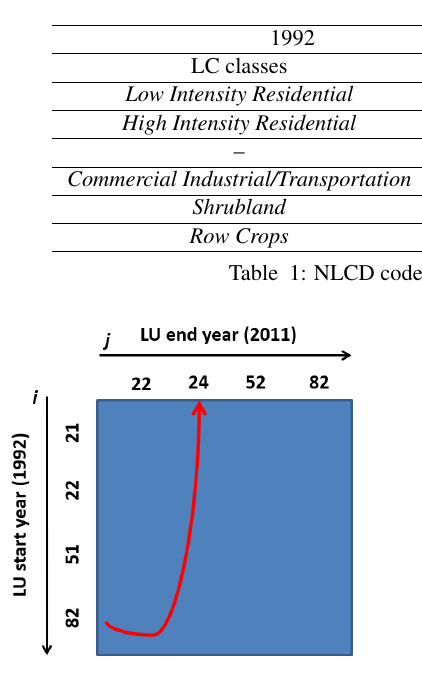
Figure 7: Matrix representation of the LC changes: the LC tran- sition from the class Row Crops to the class High Intensity Resi- dential (from i = 51 to j = 24 ) is indicated with the red